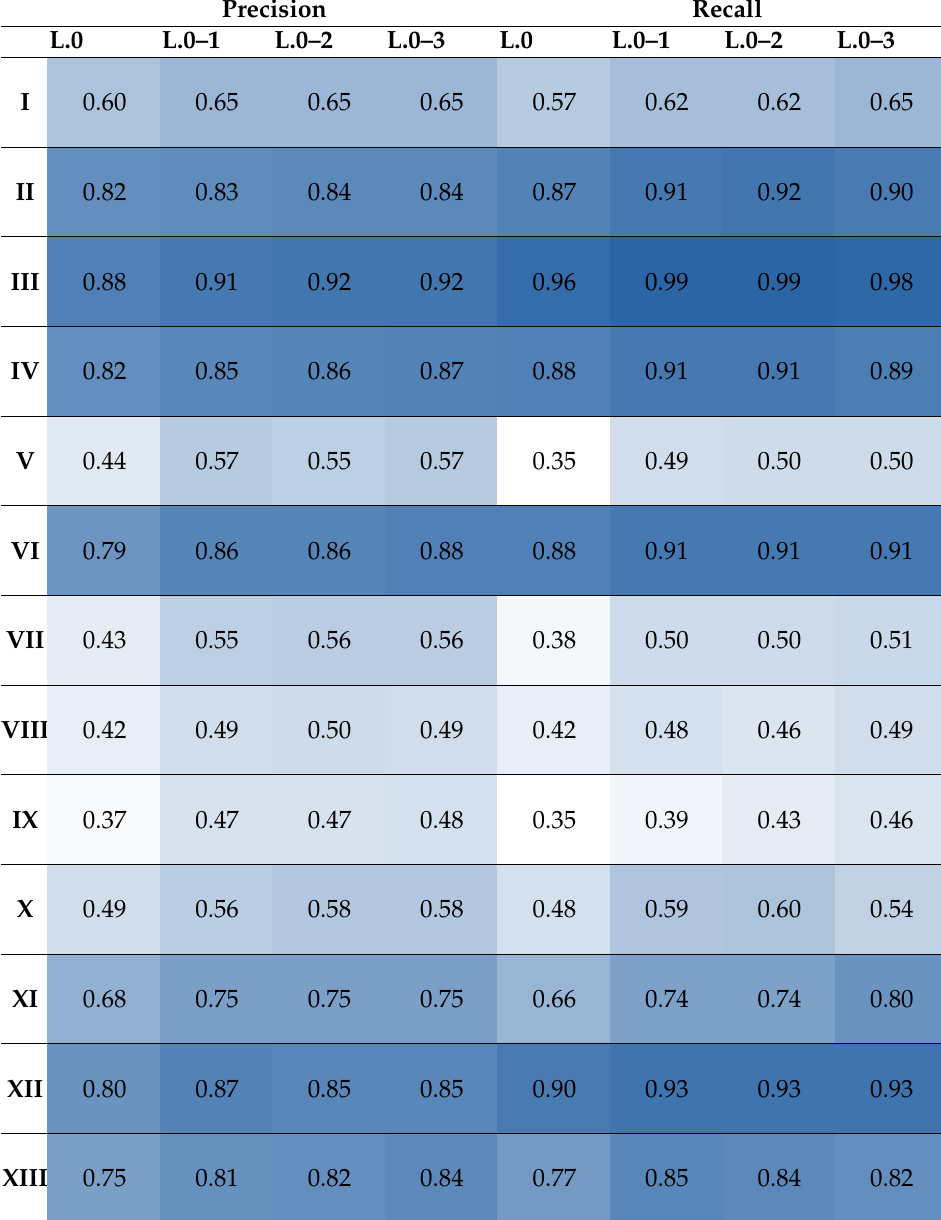
Table 7. Recall and precision scores for different LoAs. L.0 denotes that only LoA was used. L.0–1 denotes that LoA 0 and 1 were used. L.0–2 denotes that LoA 0, 1 and 2 were used. L.0–3 denotes that LoA 0, 1, 2 and 3 were used, i.e., all available OWL classes. L.0–3 corresponds to the input used for Experiment one . The blue color value indicates the magnitude of the